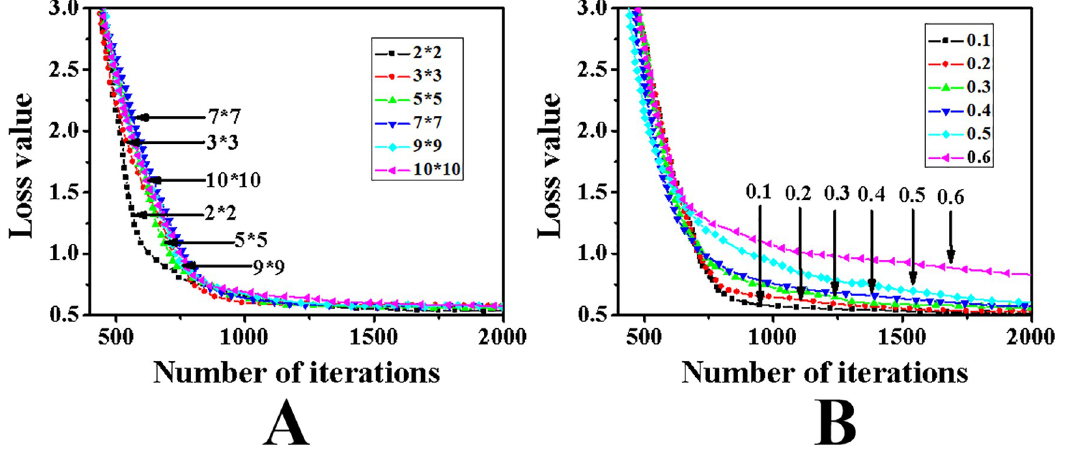
Fig 7. The influence of different parameters on the recognition accuracy of MS-CNN model (A is the change of convolution kernel size; B is the change of Dropout rate).